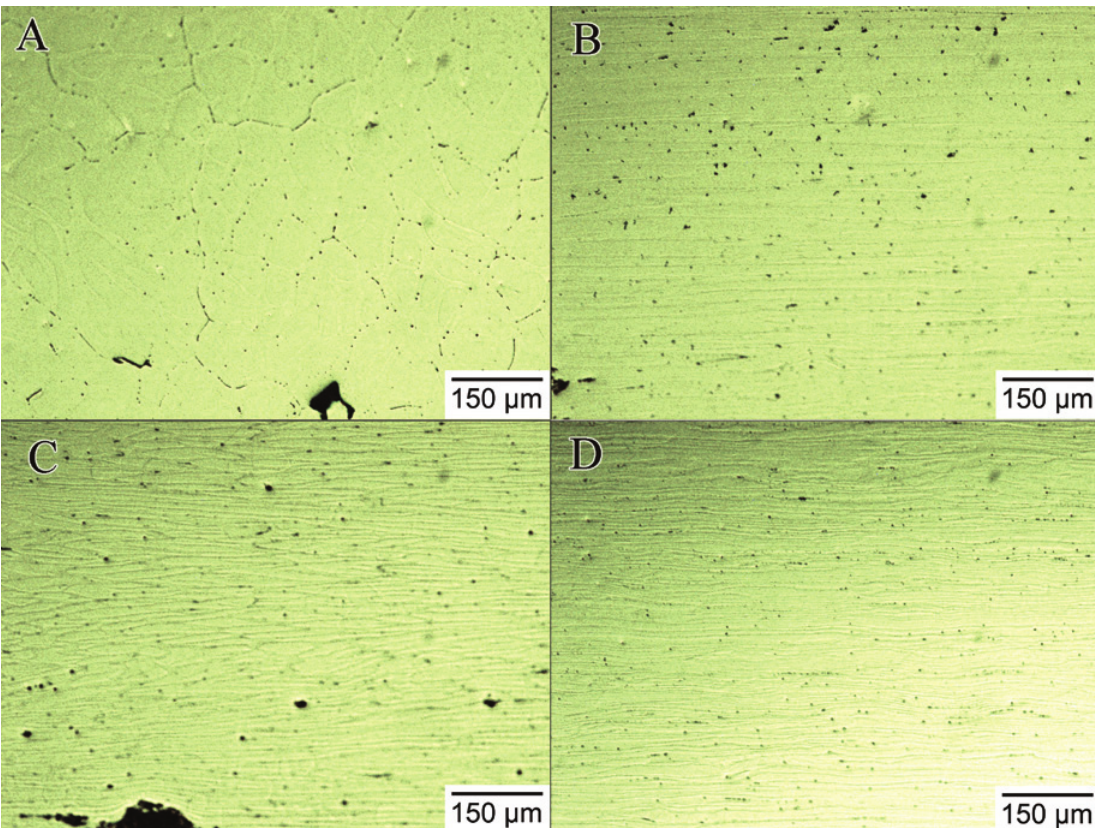
Figure 4 Microstructures of the wires at different stages of the manufacturing process. (A) Aluminum ingot treated with 1 wt% of NbB particles contained in the nanocomposite pellet, (B) aluminum wire containing 1 wt% of NbB